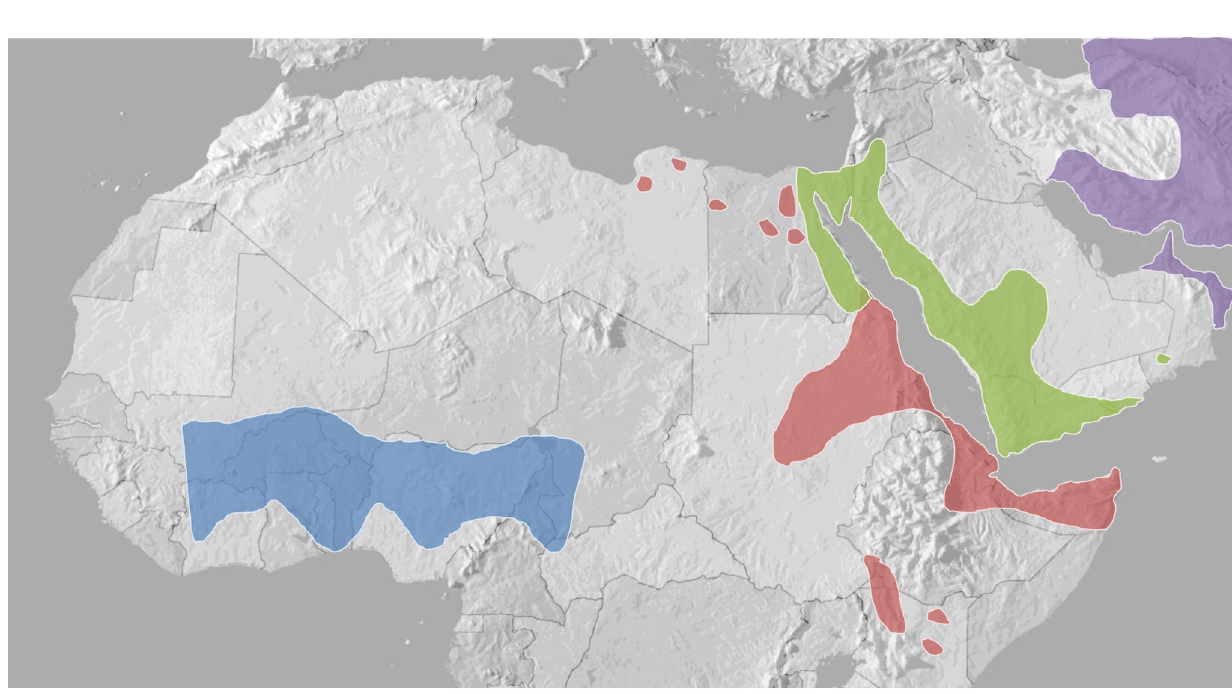
Figure 1. Distribution of four Echis species in Africa and the Middle East. Key: E. ocellatus – blue, E. pyramidum – red, E. coloratus – green, E. carinatus – purple. Distributions mapped according to the WHO venomous snake distribution database and a recent study of the genus Echis [16,35].